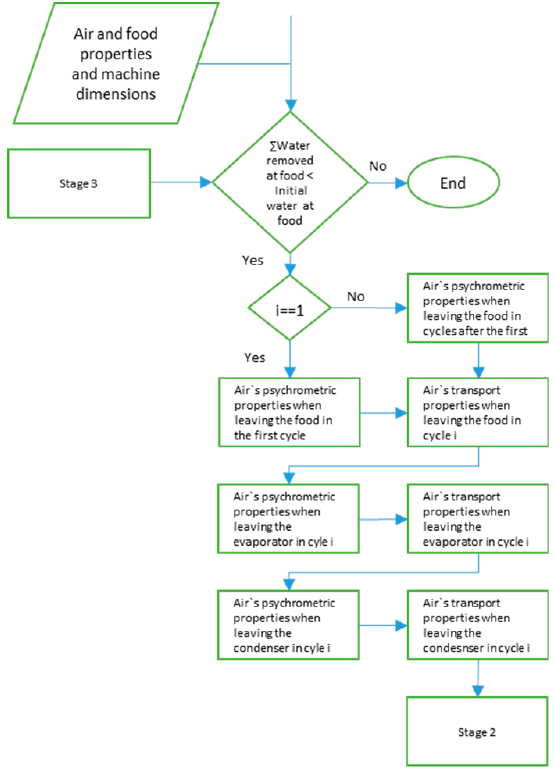
Figure 2. Stage 1 of the algorithm. The internal air analysis described in Equations (1)–(17).